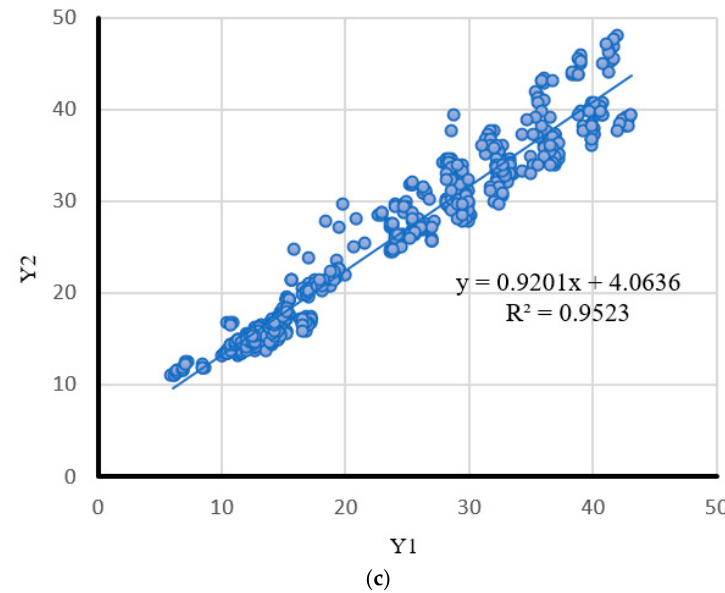
Figure 6. The histogram of the Y1 ( a ) and Y2 ( b ) and the correlation ( c ) between them.